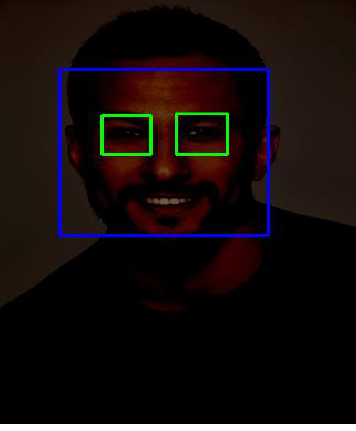
Figure 27. Slightly reduce the brightness in Figure 25.